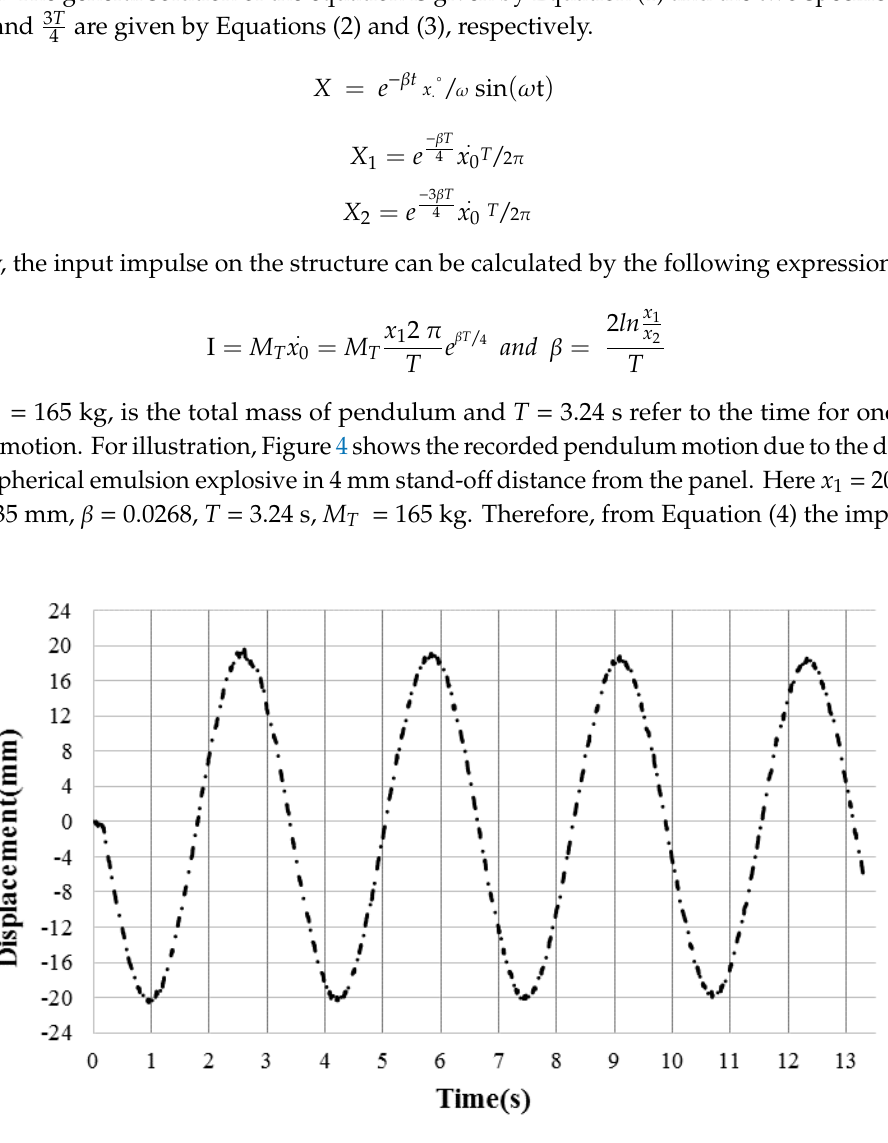
Figure 3. The blast test set up ( a ) four-cable pendulum blast system. ( b ) Schematic of the four-cable pendulum blast set up.